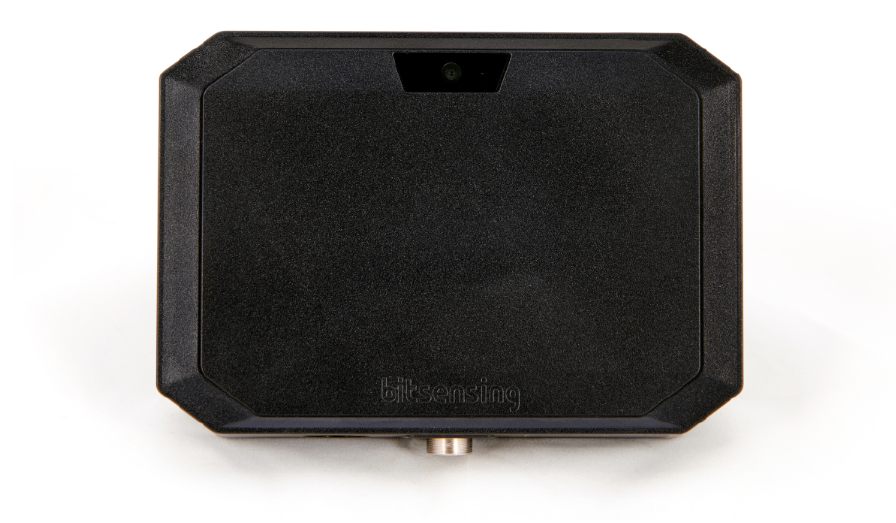
Figure 2. Traffic monitoring radar developed by Bitsensing